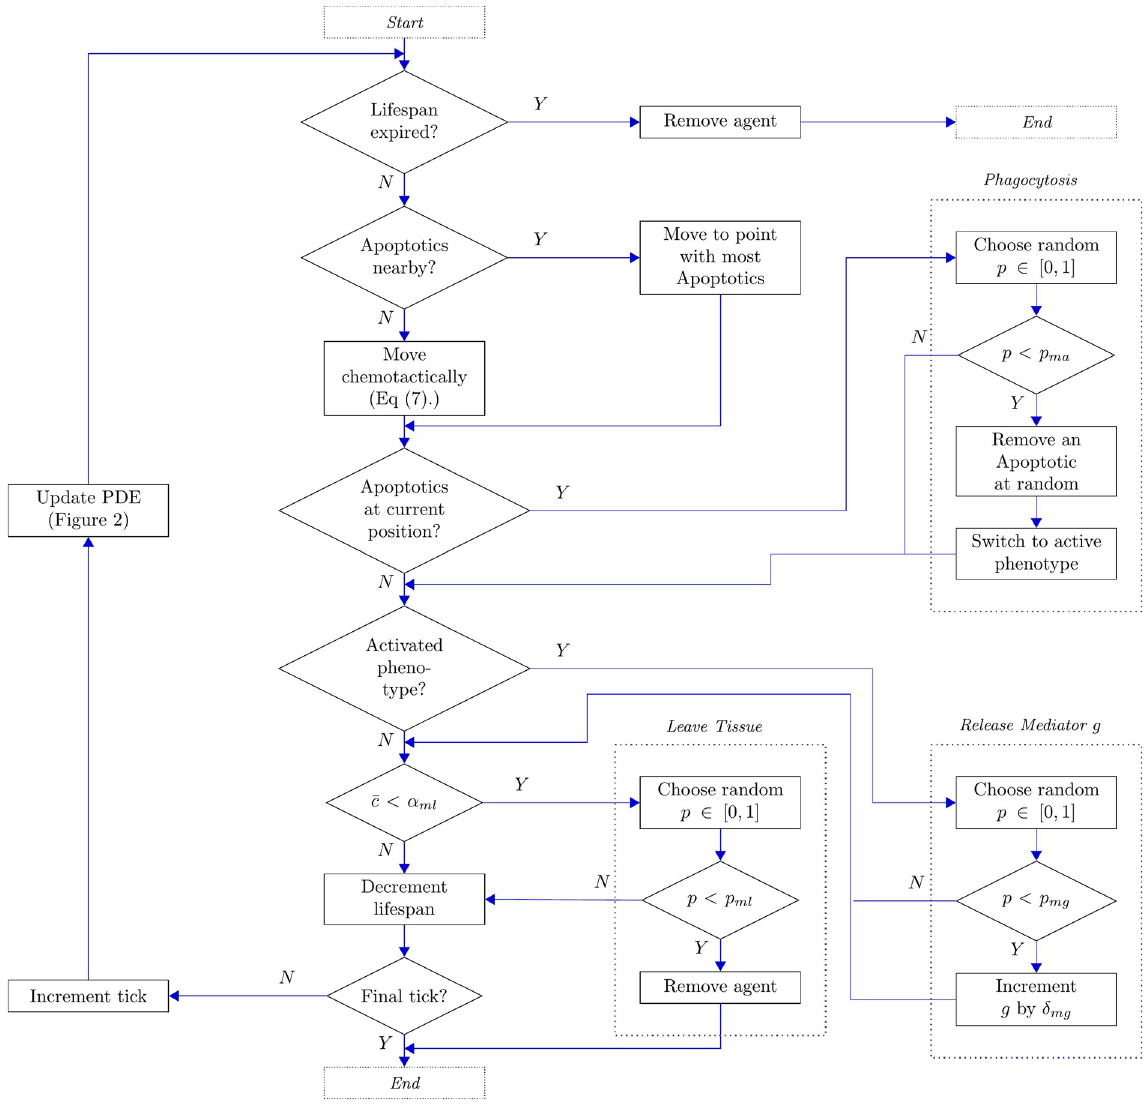
Fig 3. Flow chart illustrating the actions of each agent of the macrophage class. Here, � c represents the total concentration of mediator c in the neighbourhood of the agent.